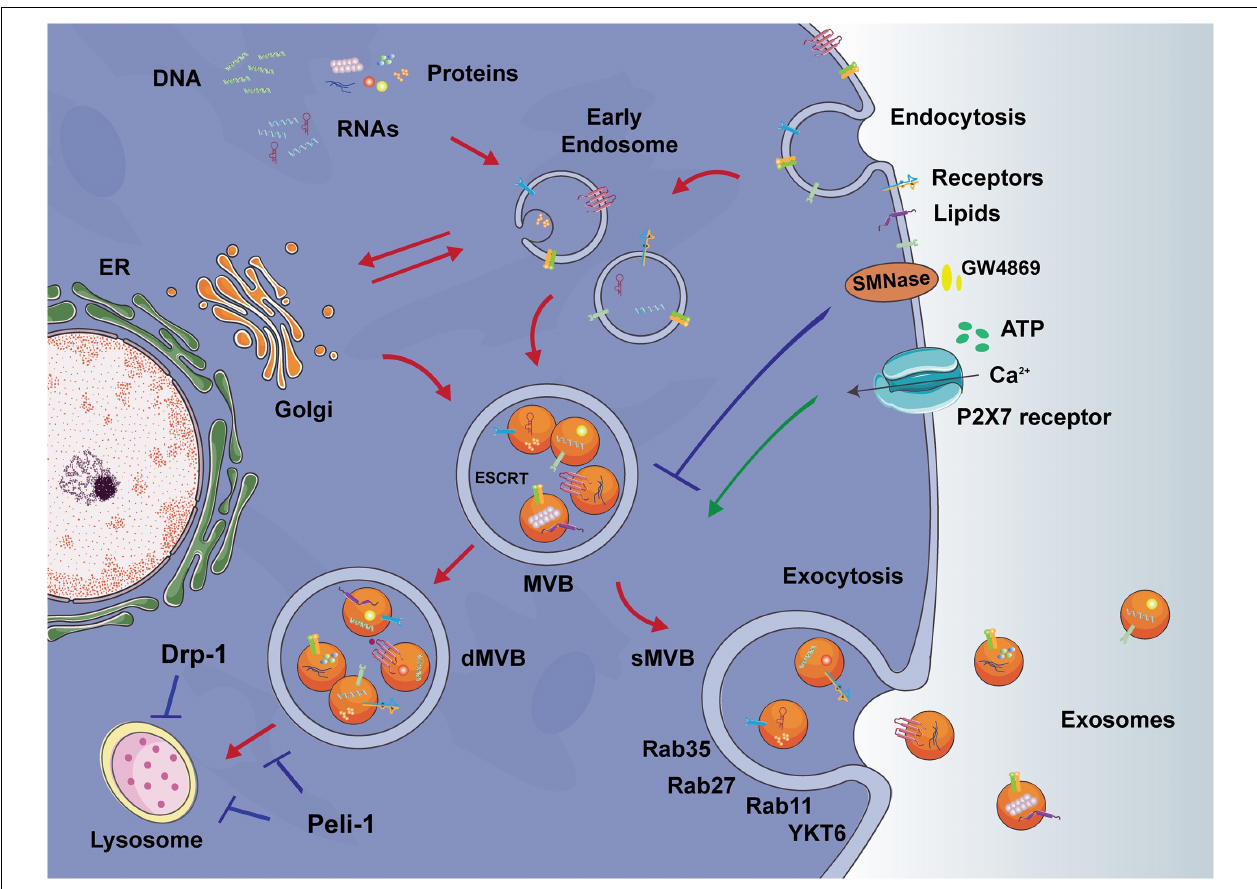
FIGURE 2 | Exosome formation and release. Endocytic pathway: Early endosomes are vesicles that originate by endocytosis at the plasma membrane. The membrane of the endosome then bud inwardly into the lumen of the endosome and form multivesicular bodies (MVBs). Secretory MVBs (sMVBs) are the cellular source of exosomes. sMVBs then fuse with the plasma membrane, releasing exosomes into the extracellular space. Secretory pathway: In the process of endosome and MVBs formation, the Golgi complex fuses with the membrane of endosome or MVBs and thus leading to the mixed membrane constituents of exosomes, including proteins from the plasma membrane or Golgi complex. Degradative MVBs (dMVBs) subsequently fuse with the lysosome, leading to MVBs content degradation, thus lysosome dysfunction directly influences the exosome release. Inhibiting E3 ubiquitin ligase Peli-1 or mitochondria fission protein Drp-1 in activated microglia might help to improve lysosome function and restore autophagy flux, hence regulating exosomes release. Other key targets to regulate exosome release include sphingomyelinase-2 (SMNase) and P2X7 receptors. SMNase is the receptor of small molecular GW4869 and the activation of which inhibits exosome release. P2X7 receptors can bind with ATP and promote the exosome